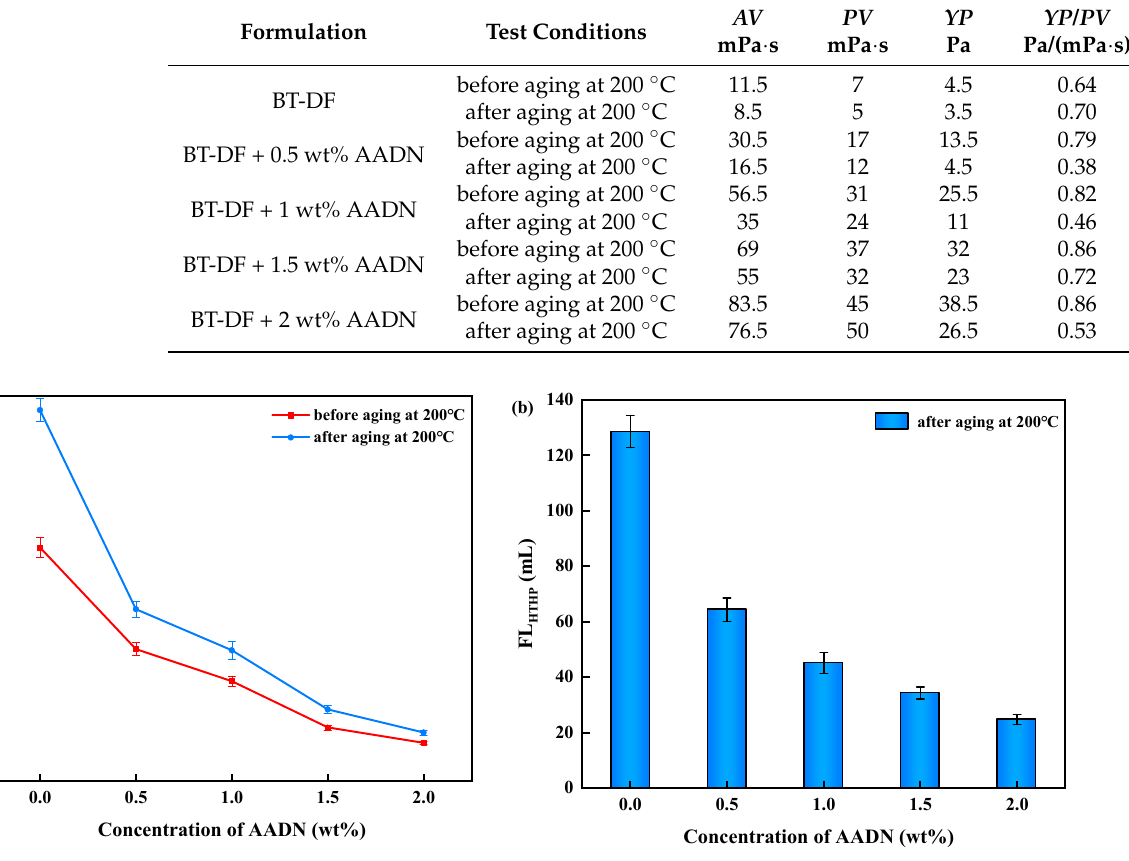
Figure 4. Effect of different AADN concentrations on filtration performance of BT-DF: ( a ) FL API before and after aging at 200 °C for 16 h; ( b ) FL HTHP before and after aging at 200 °C for 16 h.